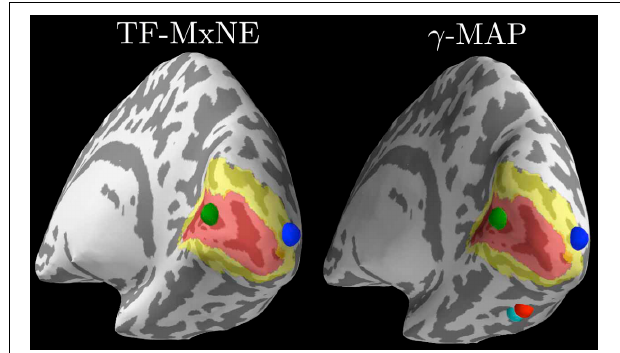
FIGURE 10 | Source localization with non-linear sparse solvers. The left plot shows results from TF-MxNE on raw unfiltered data (due to the built-in temporal smoothing), and the right plot shows results from γ -MAP on the same data but filtered below 40Hz. One can observe the agreement between both methods on the sources in the primary (red) and secondary (yellow) visual cortices delineated by FreeSurfer using an atlas. The γ -MAP identifies two additional sources in the right fusiform gyrus along the visual ventral stream. These sources that would not be naturally expected from such simple visual stimuli are weak and peak later in time, which makes them nevertheless